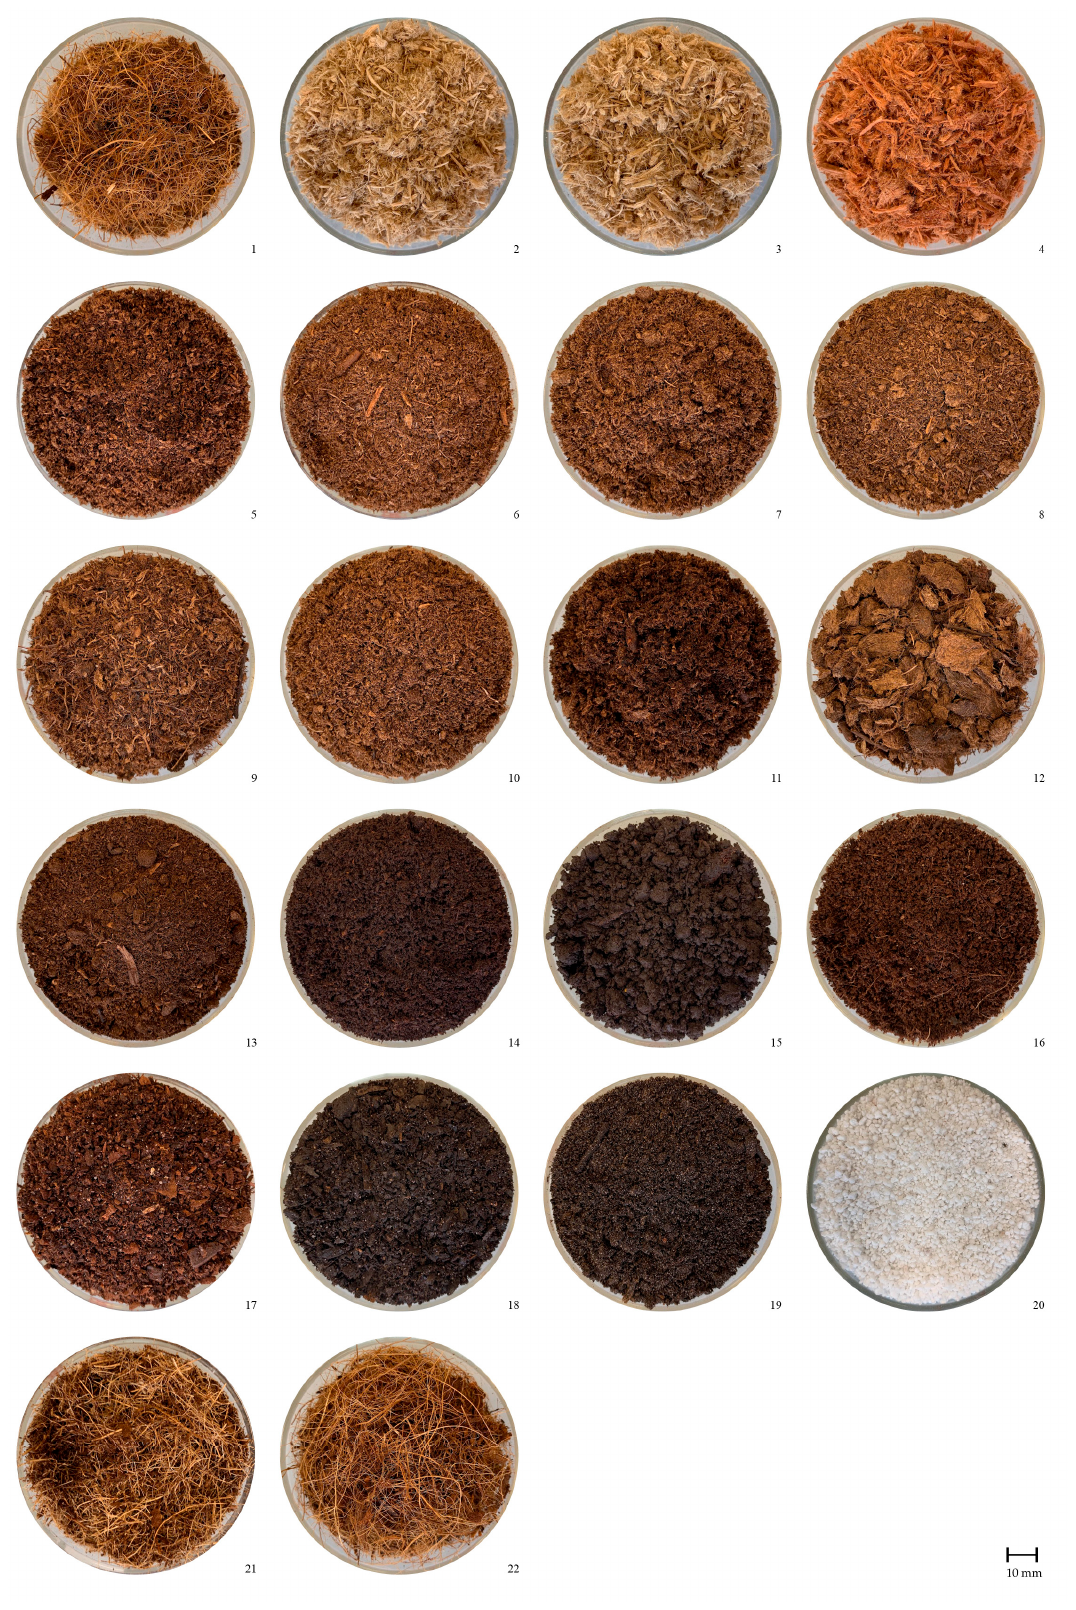
Figure 1. Raw materials studied (with identification number (#ID) referenced in Table 1).